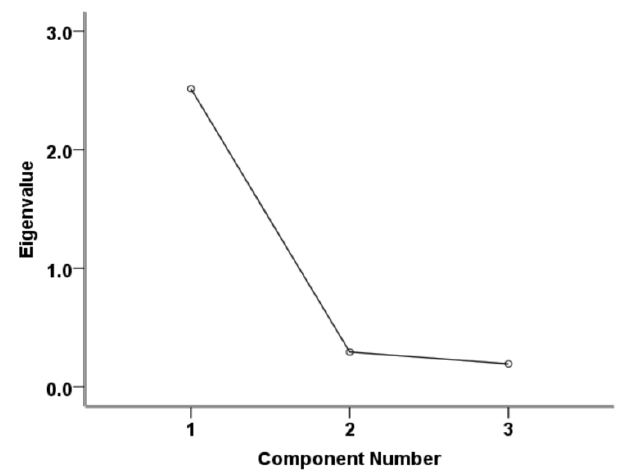
Figure 4. Scree plot of the components’ eigenvalues as estimated by the principal component analysis.